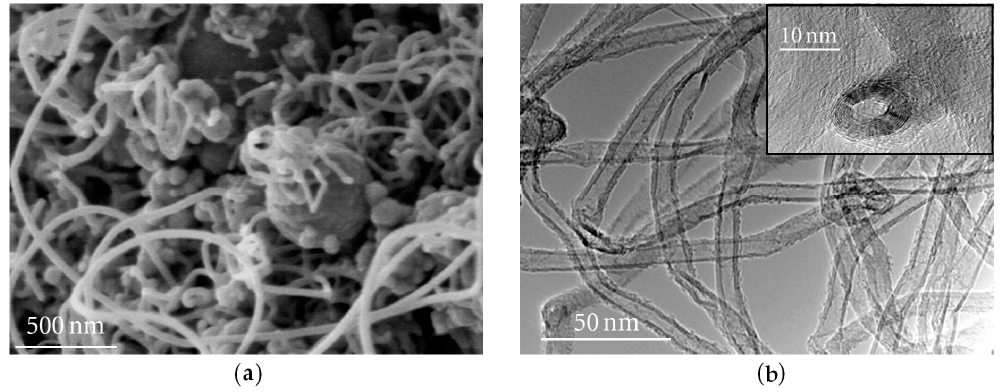
Figure 4. CNTs grown on silica particles with a 100 nm–2 µm diameter at 600 °C: ( a ) Scanning Electron Microscope image; and ( b ) Transmission Electron Microscope image (adapted from [128]).